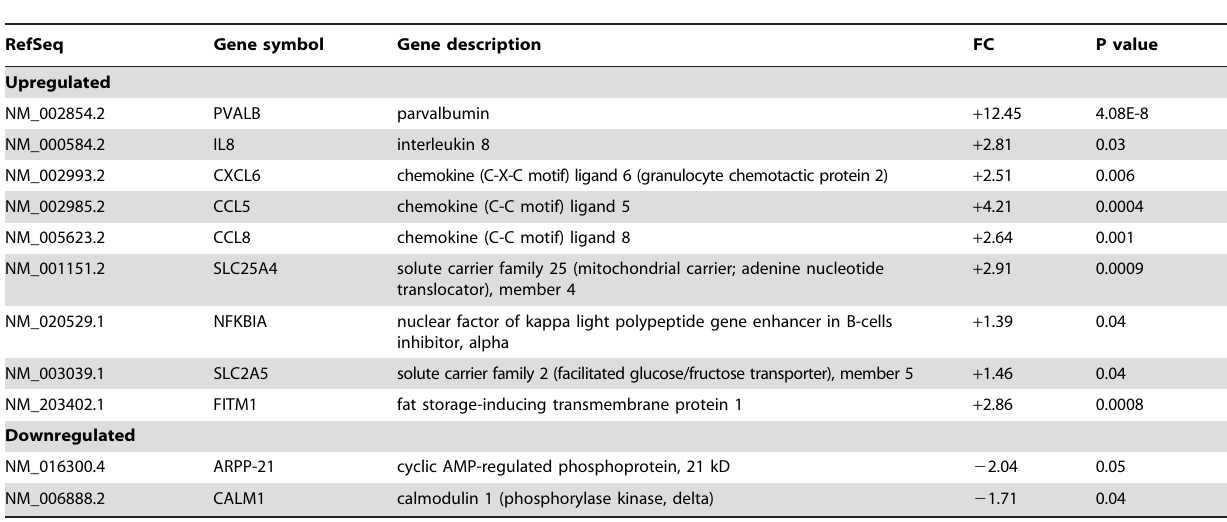
List of genes with changed expression levels in response to PGC-1 a overexpression in cultured muscle cells as validated by RT and real-time PCR and ordered as in Table 1. For each gene, the FC in gene expression was calculated from the mean values in PGC-1 a -cells versus control cells from six independent experiments performed in triplicate. FC has a positive symbol for upregulated genes and a negative symbol for downregulated genes. All columns are as in Table 1.